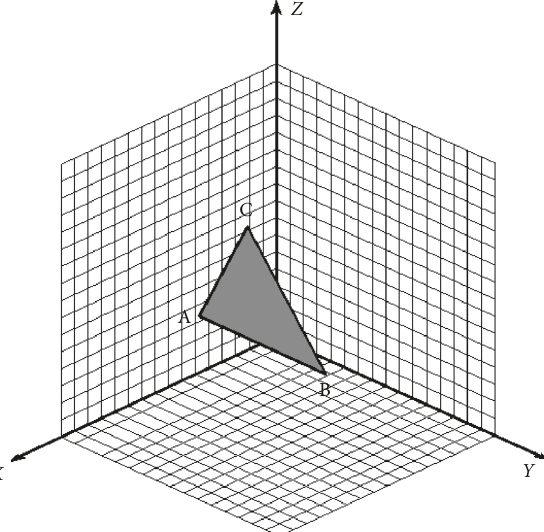
Figure 11: Triangular patch.